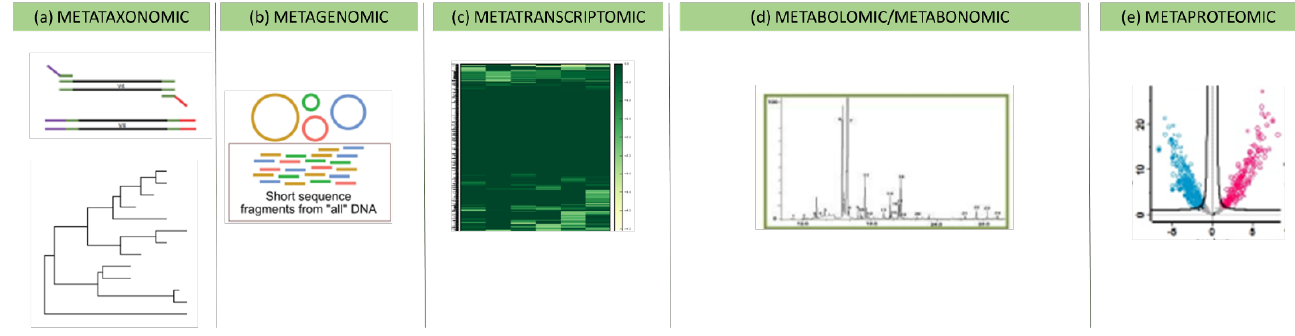
Figure 1. Schematic representation of omics techniques: ( a ) metataxonomic; ( b ) metagenomic; ( c ) metatranscriptomic; ( d ) metabolomic and metabonomic; ( e ) metaproteomic.